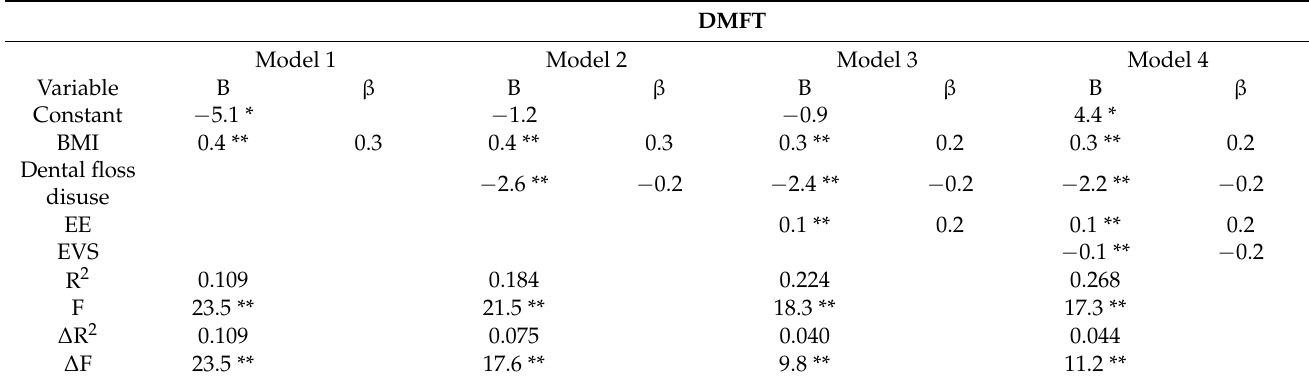
Table 2. Results of the regression analysis to predict DMFT based on BMI, dental floss disuse, EE and